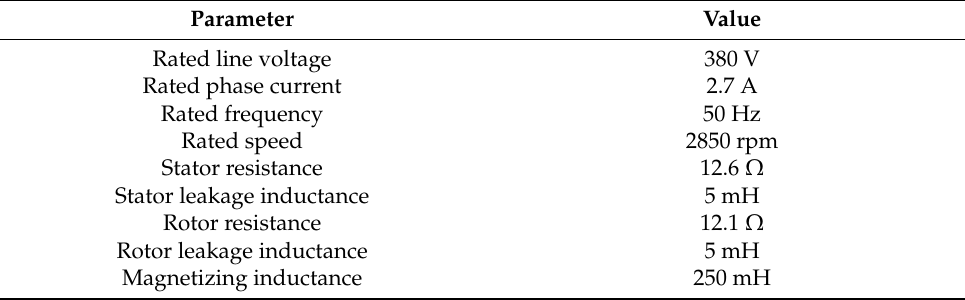
Table 1. Motor Pump Specifications and Parameters.